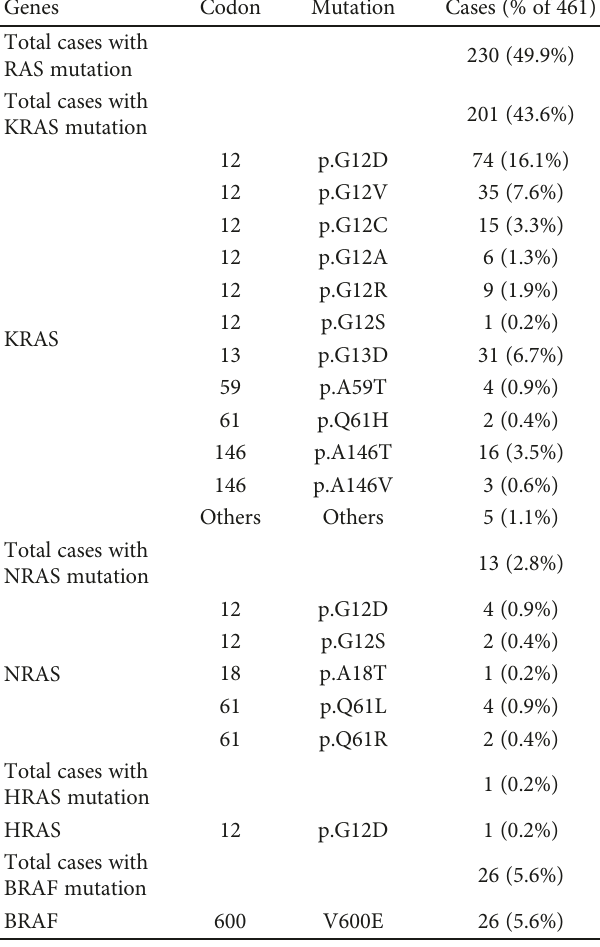
Table 1: Mutation subtype frequency distribution of RAS and BRAF genes.